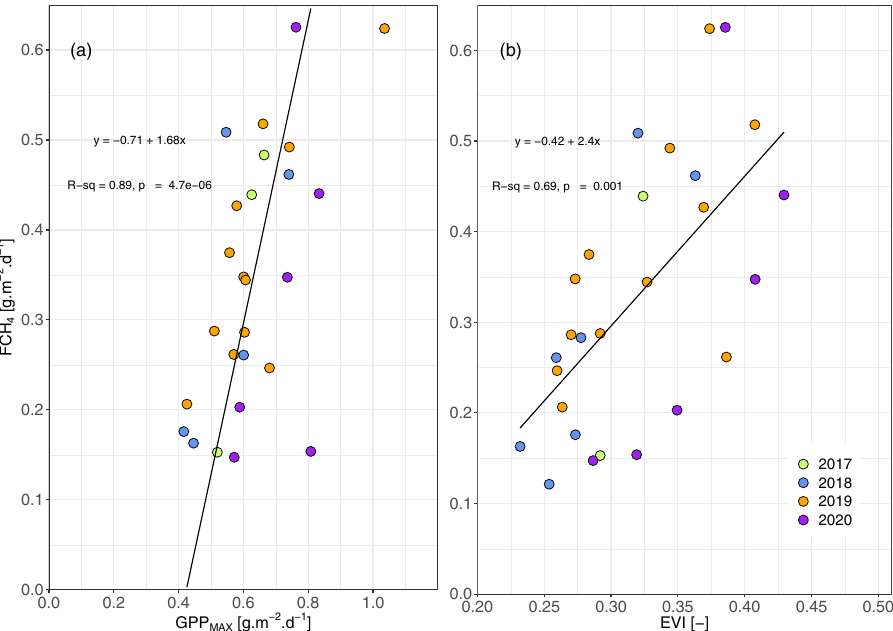
Fig. 1 Mean monthly fl ux of CH 4 measured by eddy-covariance over Cyperus papyrus . Measurements taken at Guma Lagoon (18°57 ′ 53.01 ″ S; 22°22 ′ 16.20 ″ E) in the permanently fl ooded part of the Okavango Delta from August 2017 to August 2020. Fluxes (FCH 4 ) are presented as function of ( a ) maximum gross primary productivity (GPP MAX ), and ( b ) enhanced vegetation index (EVI). The solid lines represent linear regressions (equations and t-test two-sided p -value given in the panels): standard error of ( a ) ±0.19 and 0.12, and ( b ) ±0.51 and 0.17 for slope and intercept,